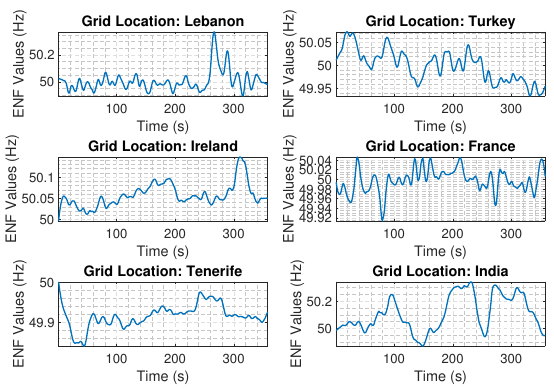
Figure 4. Sample ENF sequences extracted from audio recordings from different 50 Hz grid